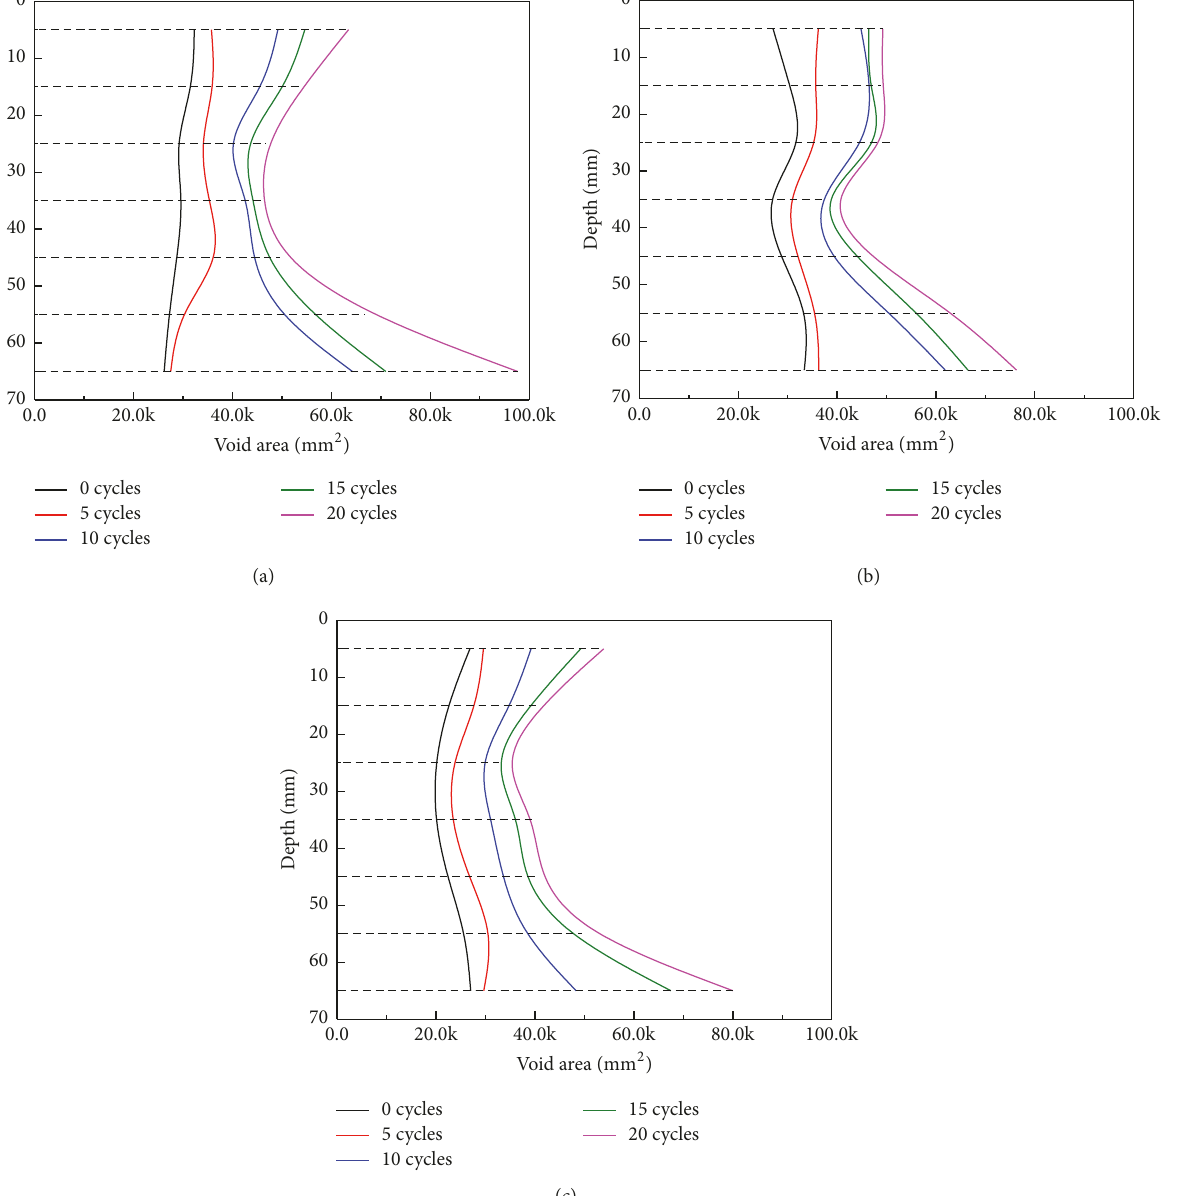
Figure 8: Distribution of the void areas of different samples after 90 d of curing: (a) cement content = 4.0%; (b) cement content = 4.5%; (c) cement content =